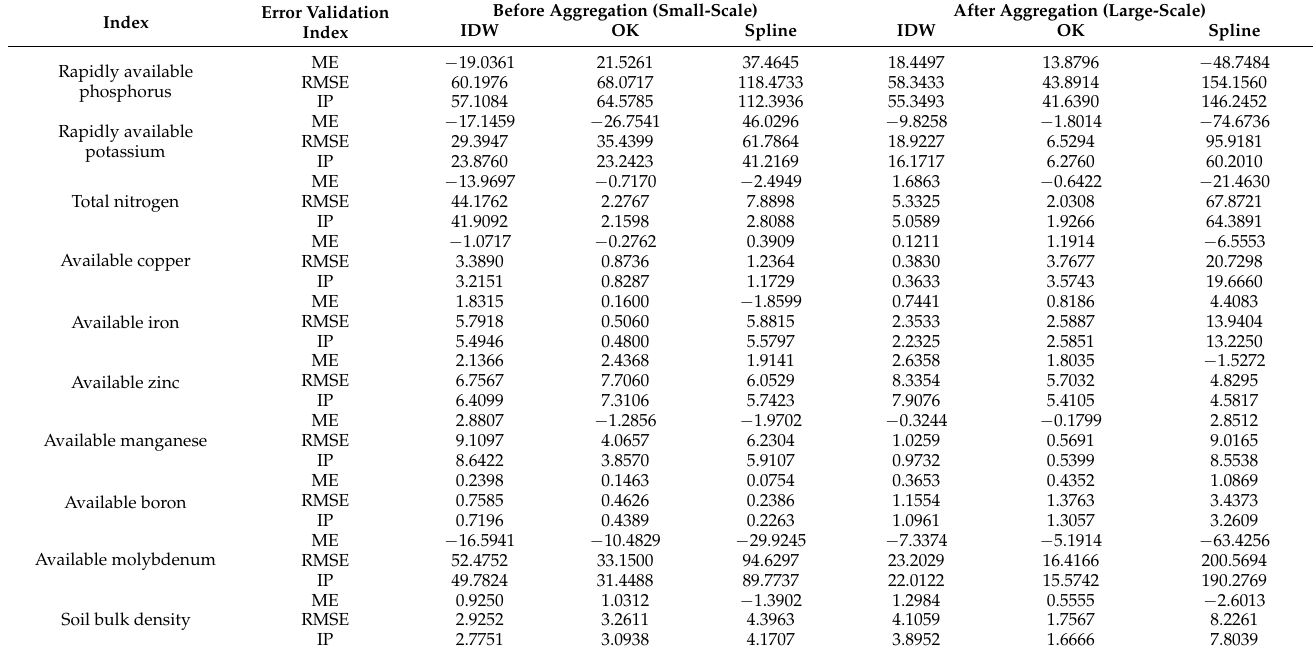
Table 2. Cross validation table of computed values of different interpolation methods with different cultivated land